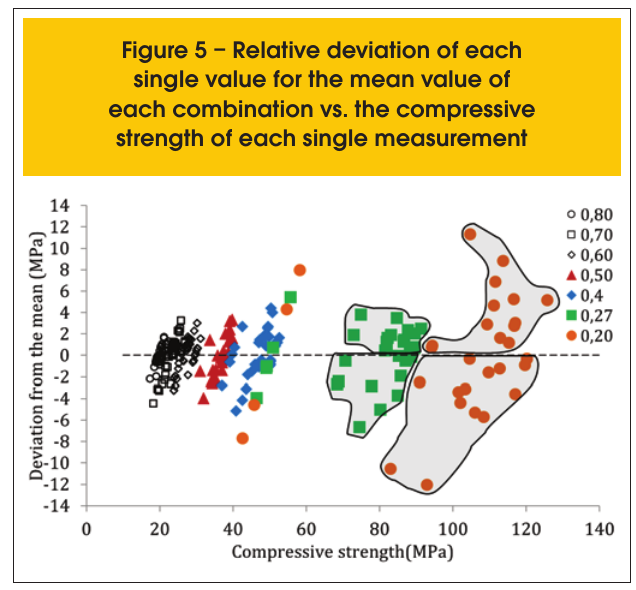
Figure 5 – Relative deviation of each single value for the mean value of each combination vs. the compressive strength of each single measurement